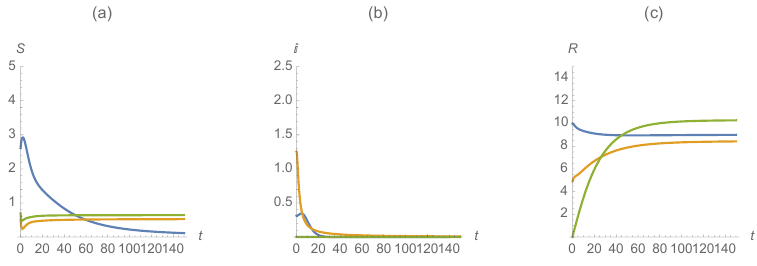
Figure 10. ( a ) S j , ( b ) I j , and ( c ) R j . The first disease is represented in blue, the second in orange and those susceptible/infected/recovered by diseases in